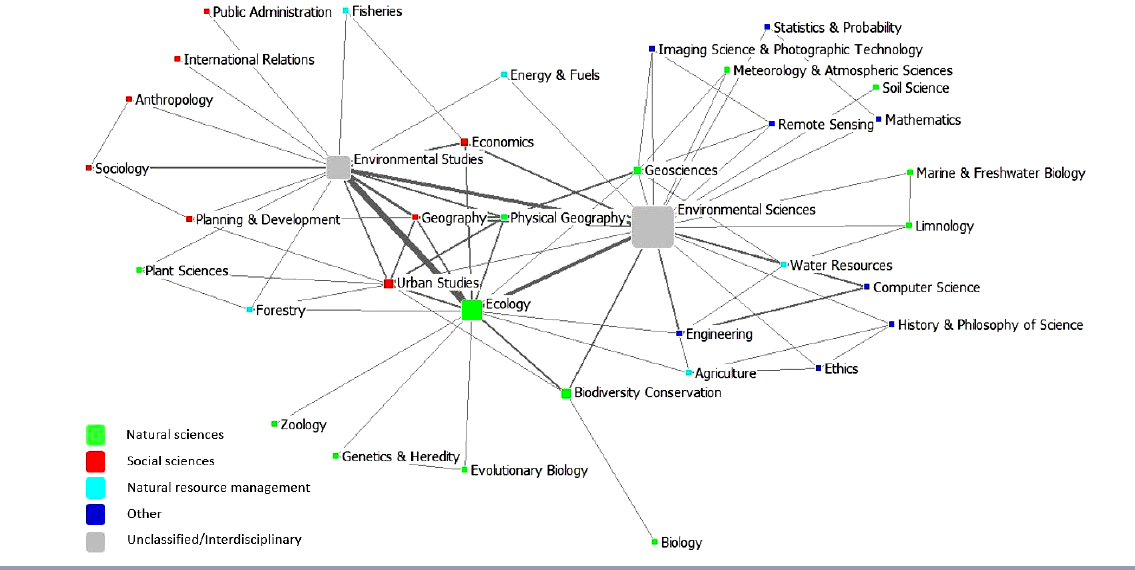
Fig. 3 . Disciplinary integration of social-ecological systems (SES) studies based on abstract review (n = 700). Disciplines were assigned to papers based on the classification system used by the Web of Science database according to journal. Given our focus on environmental-related literature, the majority of the SES studies in our review were assigned to either environmental studies or environmental sciences. The graph was generated using a spring embedding algorithm in the Netdraw software package, which assigns locations to nodes such that nodes with the smallest path lengths are closer together (Krempel 2011). Thus, a discipline placed far from the rest of the network indicates low integration of this discipline into SES research. The bigger the size of the node, the higher the betweenness score for the corresponding discipline, thus suggesting an important role in integrating other disciplines to SES research. The width of the line connecting nodes denotes how often two disciplines are being integrated.